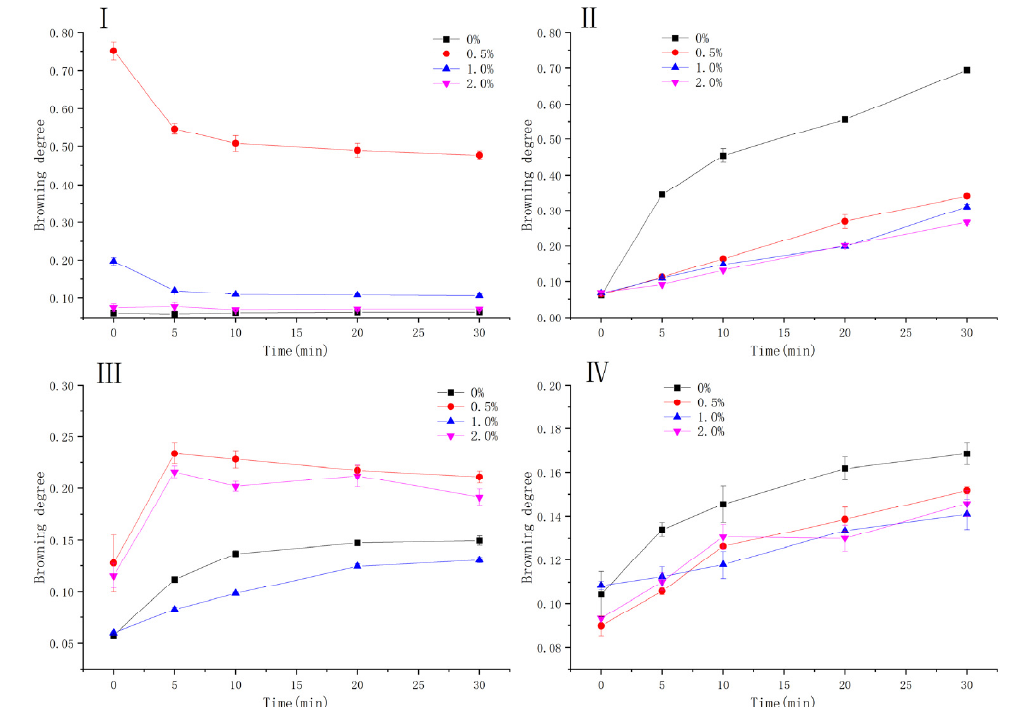
Figure 12. The browning degree of enzymatic browning products of ( I ) Catechin ( II ) Epicatechin ( III ) Caffeic acid ( IV ) Chlorogenic acid under the effect of different concentrations of eugenol.